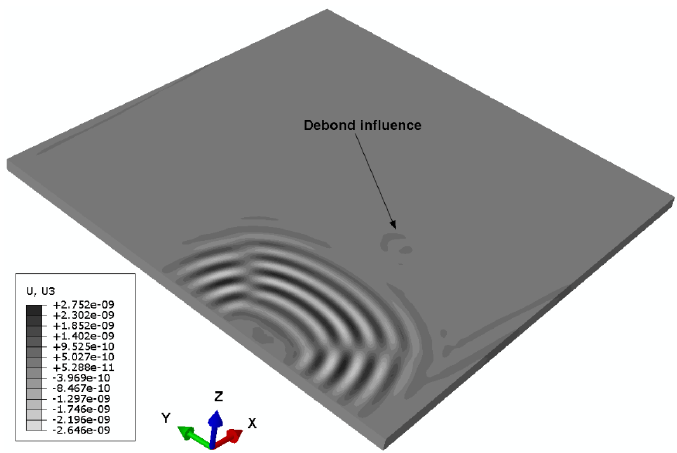
Figure 7. Waveform plot showing the debond influence on the guided wave propagation.